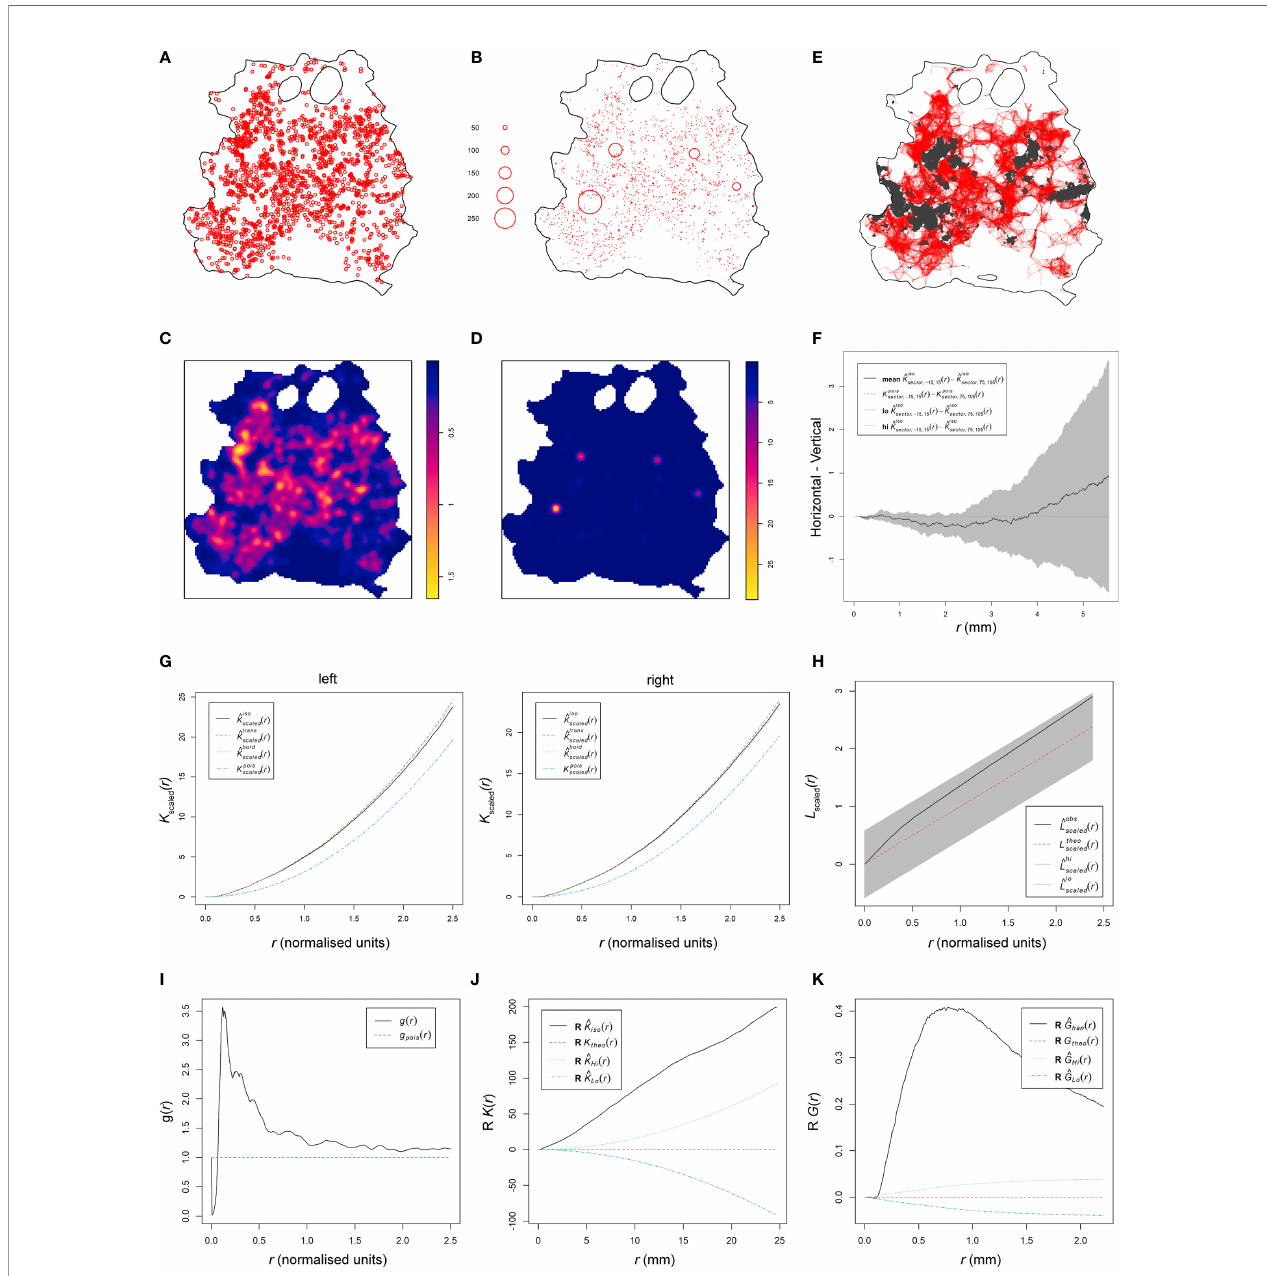
FIGURE 4 | Spatial point pattern analysis of skin parasite patch distribution. All graphs are examples for spatial point pattern analysis based on the RAG4 data. (A) Spatial point pattern of skin parasite patches based on center of mass of each detected patch without respective marks. (B) Spatial point pattern of skin parasite patches based on center of mass of each detected patch with respective patch area mark. (C) Patch intensity representation of skin parasite patches based on center of mass of each detected patch without respective marks. (D) Patch intensity representation of skin parasite patches based on center of mass of each detected patch with respective patch area mark. (E) Representation of a cluster analysis output linking all patches whose patch borders are ≤ 3.9 mm into a network. (F) Graphical representation of the isotropy test showing the theoretical Poisson process (red dotted line), the RAG4 data (black solid line), and the global envelopes (gray). (G) Graphical representation of correlation-stationary test based on a locally scaled K-function. The two graphs show the separate distribution analysis of the left and right half of the point shown in panel (A) . (H) Scaled L-function showing the theoretical Poisson process (red dotted line), the RAG4 data (black solid line), and the global envelopes (gray). (I) Pair correlation function showing the theoretical Poisson process (red dotted line) and the RAG4 data (black solid line). (J) Data points independence test based on K-function of the data residuals, showing the theoretical Poisson process (red dotted line), the RAG4 data (black solid line), and the upper (green) and lower limits (blue) of the con fi dence intervals of the theoretical Poisson process. (K) Data points independence test based on nearest-neighbor (G-) function of the data residuals, showing the theoretical Poisson process (red dotted line), the RAG4 data (black solid line), and the upper (green) and lower limits (blue) of the con fi dence intervals of the theoretical Poisson